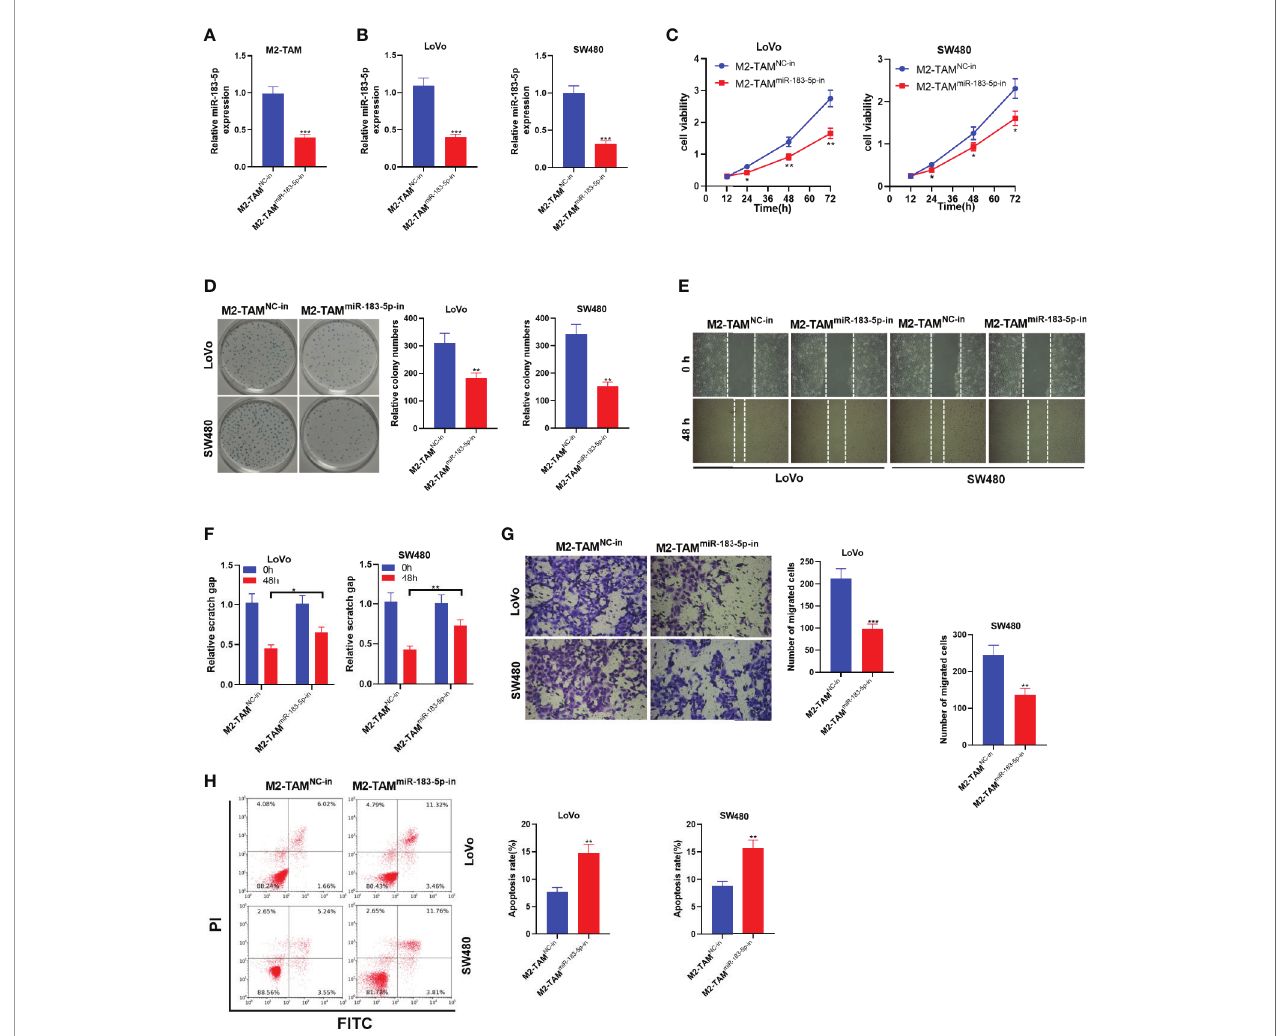
FIGURE 4 | M2-TAM-Exo knocking down miR-183-5p attenuated the malignant phenotype of CC cells. MiR-183-5p-in was transfected into M2-TAM and then co- cultured with LoVo and SW480 cells, respectively. (A) The miR-183-5p pro fi le in M2-TAM was monitored by qRT-PCR. (B) qRT-PCR veri fi ed the miR-183-5p pro fi le in LoVo and SW480 cells. (C, D) CCK-8 assay and colony formation assay were implemented to detect CC cell proliferation. (E) The ability of cell colony formation was tested. (F) Detection of cell migration by wound healing test. (G) Cell invasion was measured by Transwell assay. (H) Cell apoptosis was examined by FCM. * P < 0.05, ** P < 0.01, *** P < 0.001 ( vs . The M2-TAM NC-in group).